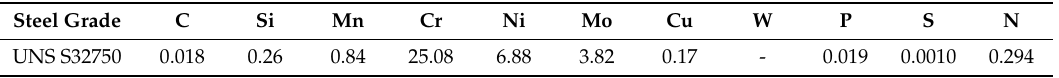
Table 1. Chemical composition of the investigated steel (wt%).